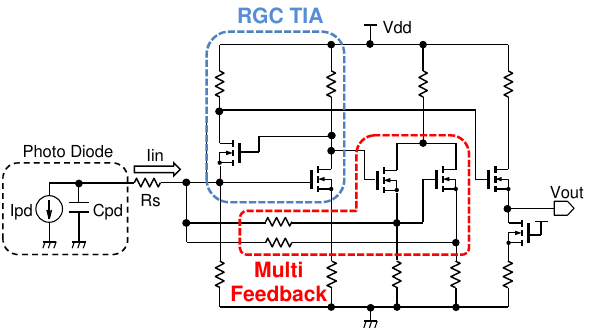
Figure 2. Schematic of a conventional